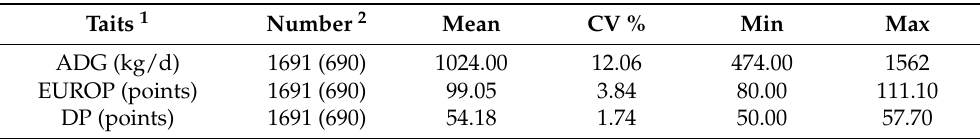
Table 1. Descriptive statistics of the target phenotypic data obtained from Rendena young bulls under performance